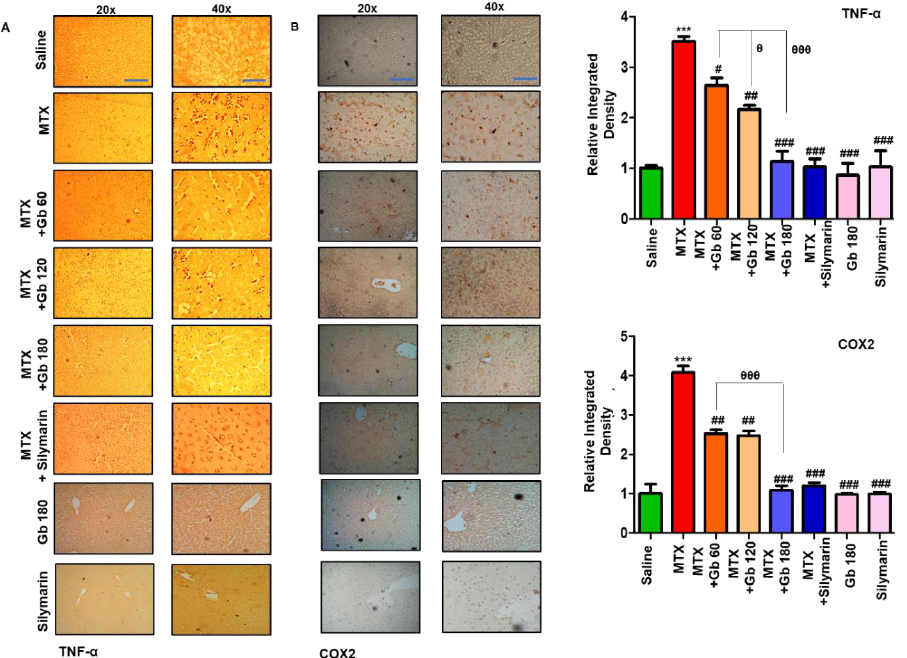
Figure 4. Gb attenuated inflammatory markers. The presented images indicate the immunoreactivity of ( A ) TNF-α and ( B ) COX2. Scale bars = 50 μm (20× magnification) and 20 μm (40× magnification);